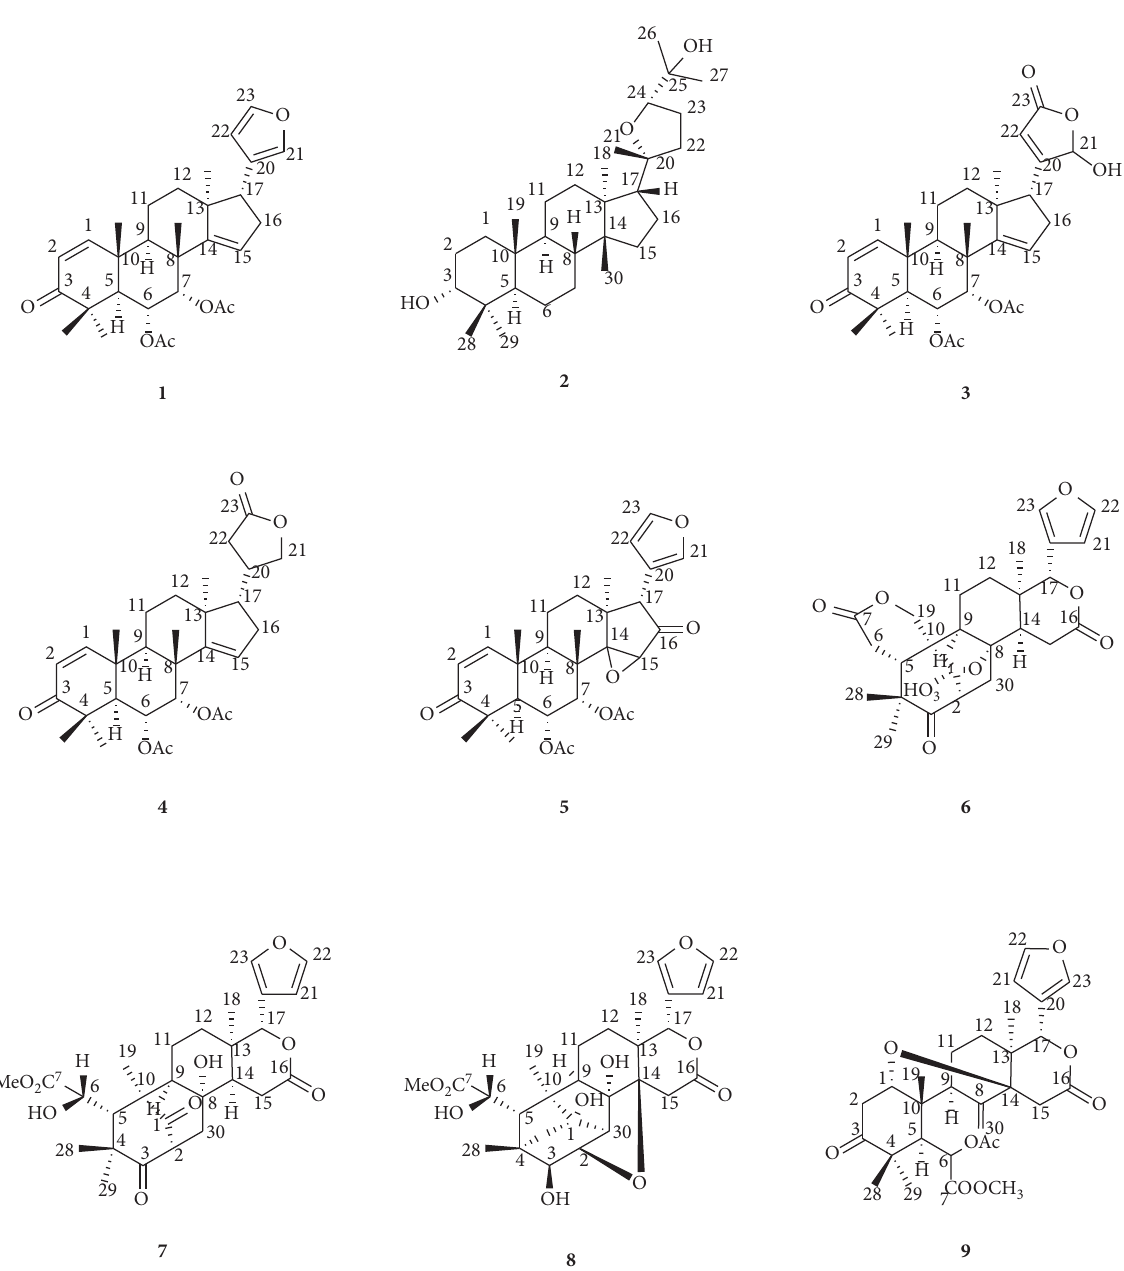
Figure 1: Chemical structures of the limonoids isolated from Melia dubia ( 1 – 2 ), Aphanamixis polystachya ( 3 – 5 ), and Swietenia macrophylla ( 6 – 9 ). ( 1 ) Dysobinin. ( 2 ) (3 α , 8R, 9S, 20R, 24S)-20,24-Epoxytirucalla-3, 25-diol. ( 3 ) Chisocheton compound G. ( 4 ) Chisocheton compound E. ( 5 ) 6 α- Acetoxyepoxyazadiradione VI. ( 6 ) Seneganolide. ( 7 ) Khayanone. ( 8 ) Khayanolide B. ( 9 ) 6-Acetoxy-methyl